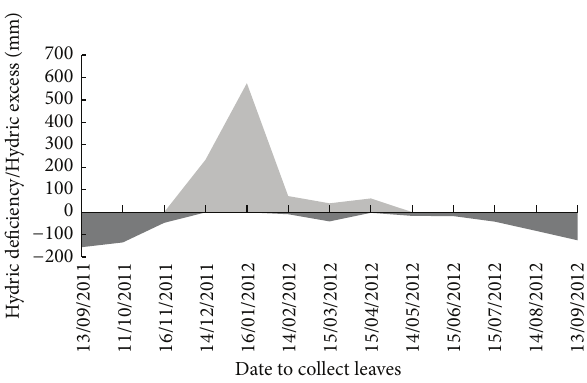
Figure 5: Climatologic water balance of Thornthwaite. From September 2011 to September 2012. Observe that the accumulation period is the same as the litterfall